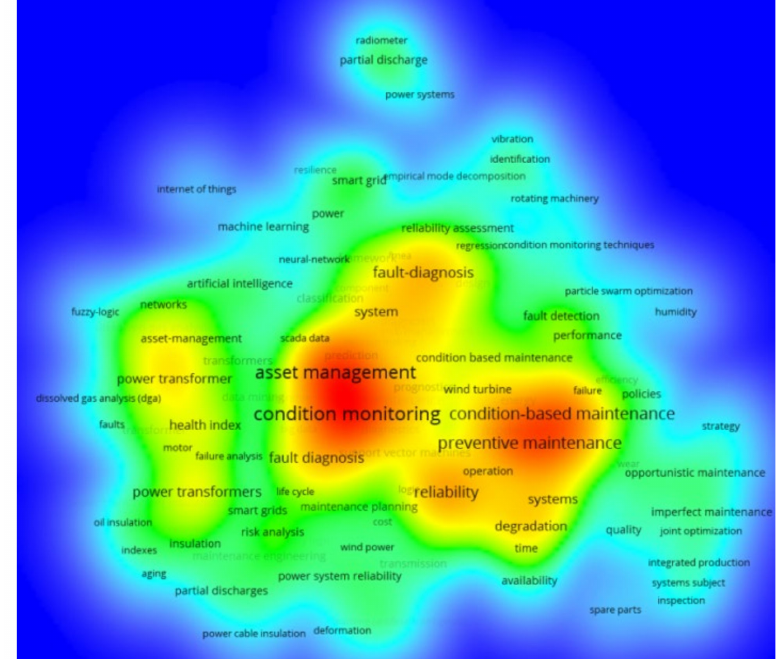
Figure 6. Density visualization of keywords from WoS